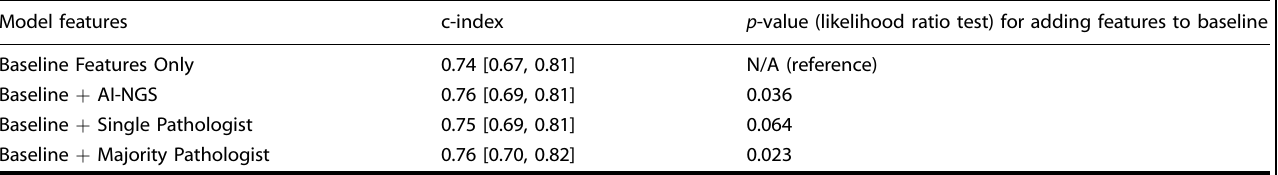
Table 4. Prognostic performance using summation of histologic components in combination with baseline clinical and pathologic features. Model